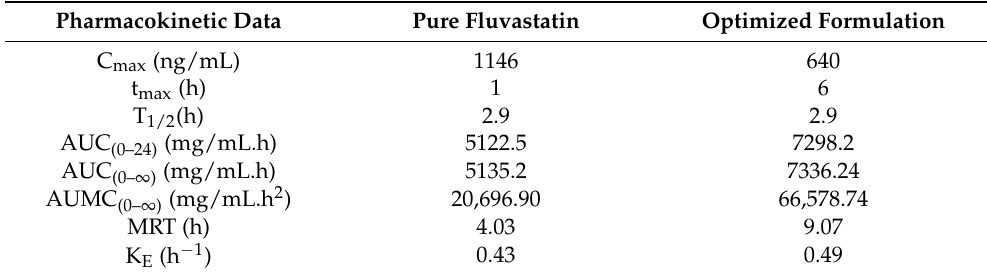
Figure 9. Pure fluvastatin and its optimized formulation plasma time profiles (Data represents mean of 6 determinations ± SEM). Table 5. Pharmacokinetic data of pure fluvastatin and its optimized